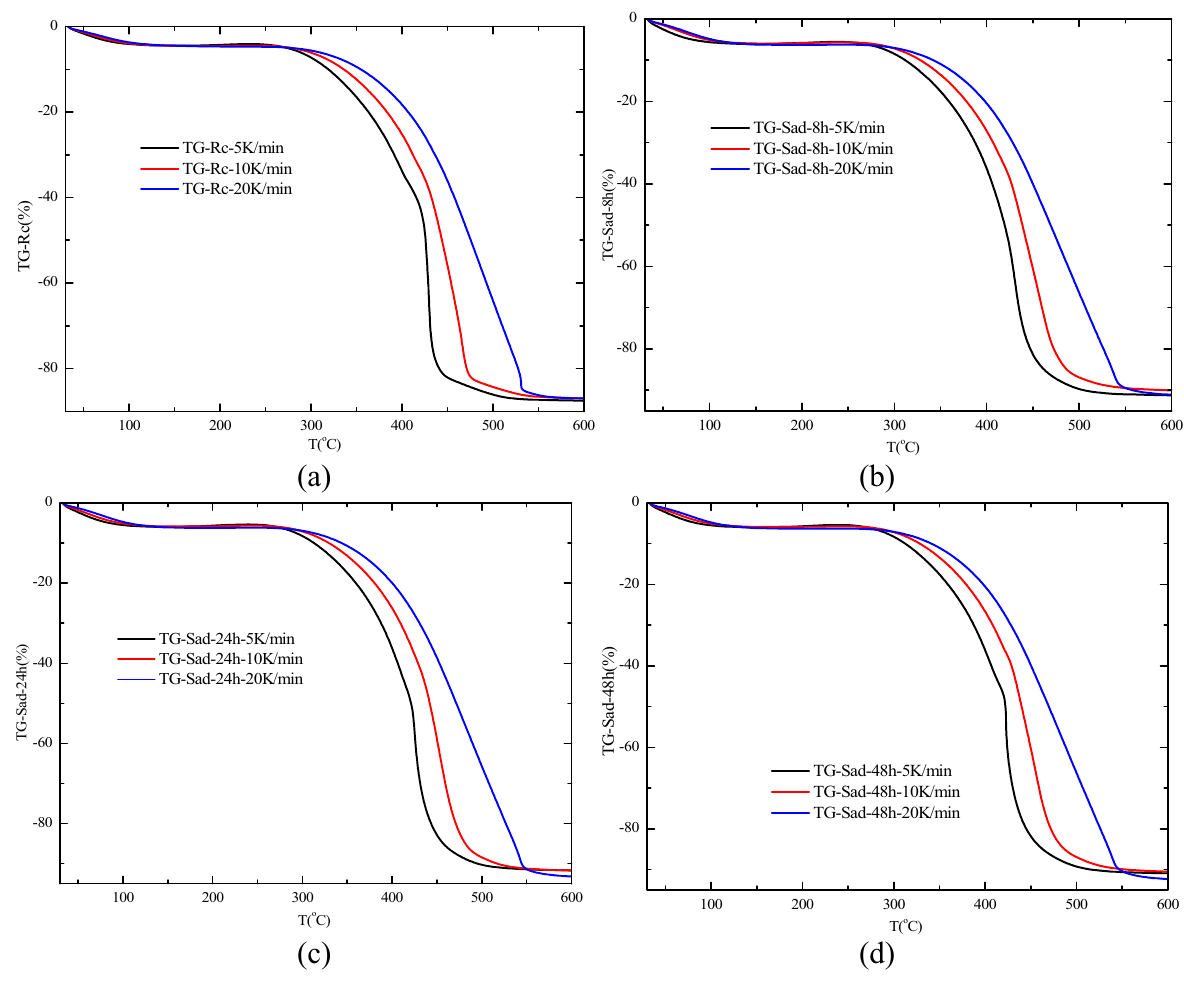
Figure 9. Thermogravimetric curves of coal samples for different heating rates. ( a ) R C , ( b ) Sad-8 h, ( c ) Sad- 24 h, ( d ) Sad-48